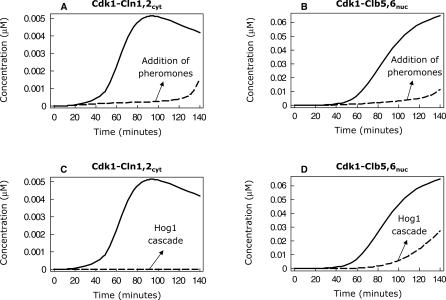
Effect of Signaling Pathway Activation on Cell Cycle ProgressionThe effects of the pheromone pathway (A,B) and the stress-response Hog1-dependent pathway (C,D) on Cdk1-Cln1,2cyt (left panels) and Cdk1-Clb5,6nuc (right panels) are reported. In each panel, basal wild-type is shown in black and “activated pathways” as a dotted line.